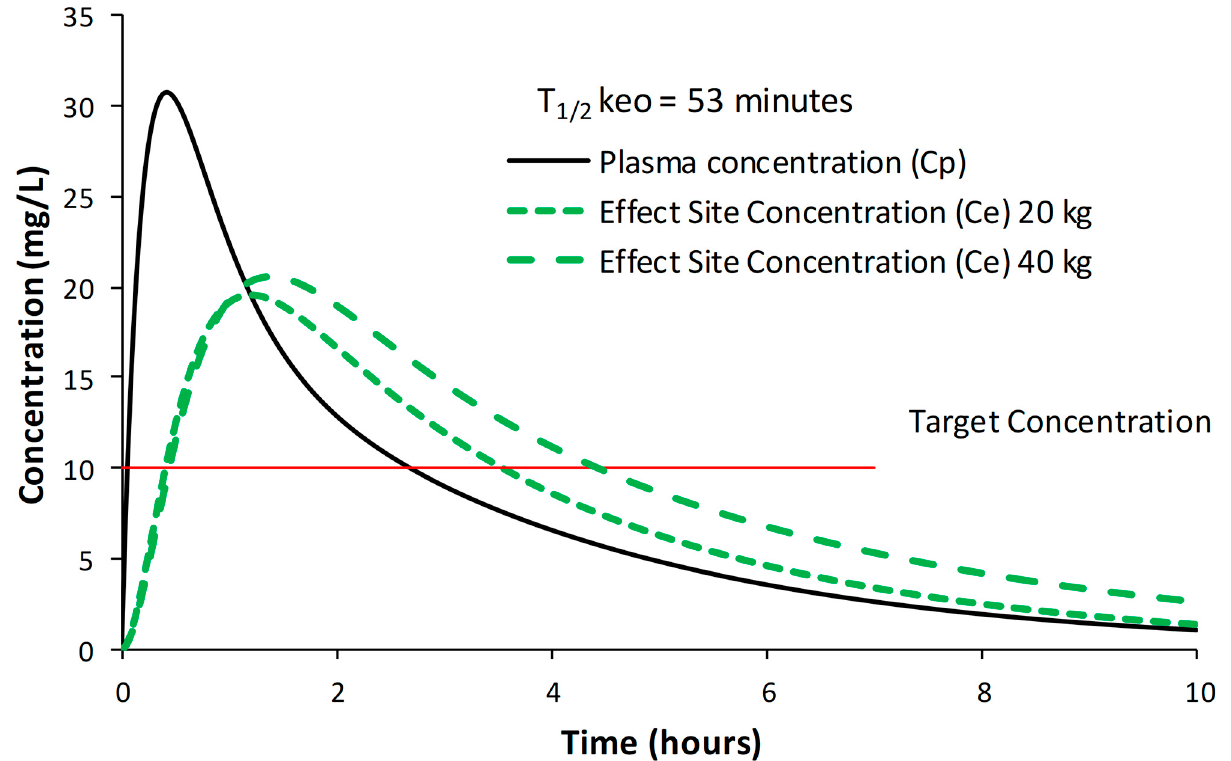
Figure 2. Simulated time–concentration profiles are shown for a loading dose of acetaminophen of 30 mg/kg in a 6-year-old, 20 kg child (FFM 16.4 kg, BMI 15.12 kg/m 2 ). Effect compartment concentrations of 10 mg/L are achieved at 25 min and decrease below this concentration at 3.5 h. While the loading dose (30 mg/kg) is the same for obese and lean children, clearance determines the duration of time that concentrations are above 10 mg/L. The duration of concentration above 10 mg/L in a 6-year-old, 40 kg child (FFM 24.7 kg, BMI 30.25 kg/m 2 ) is longer.